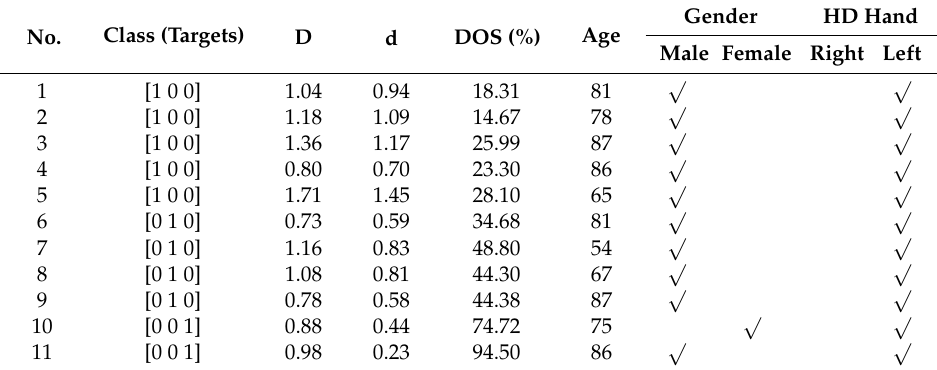
Figure 4. ( a ) B-mode ultrasound image of DOS measurement area; ( b ) the cross-section of the vascular access: the stenosis lesion diameter d and normal vessel diameter D [14]. Table 1. The data of HD patients.